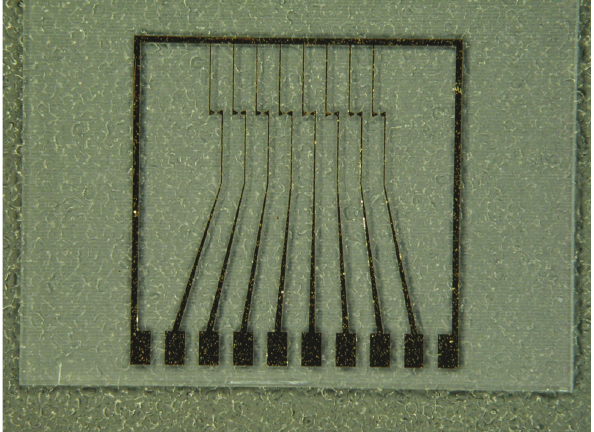
Figure 6: Photograph of the bow-tie array on quartz substrate.